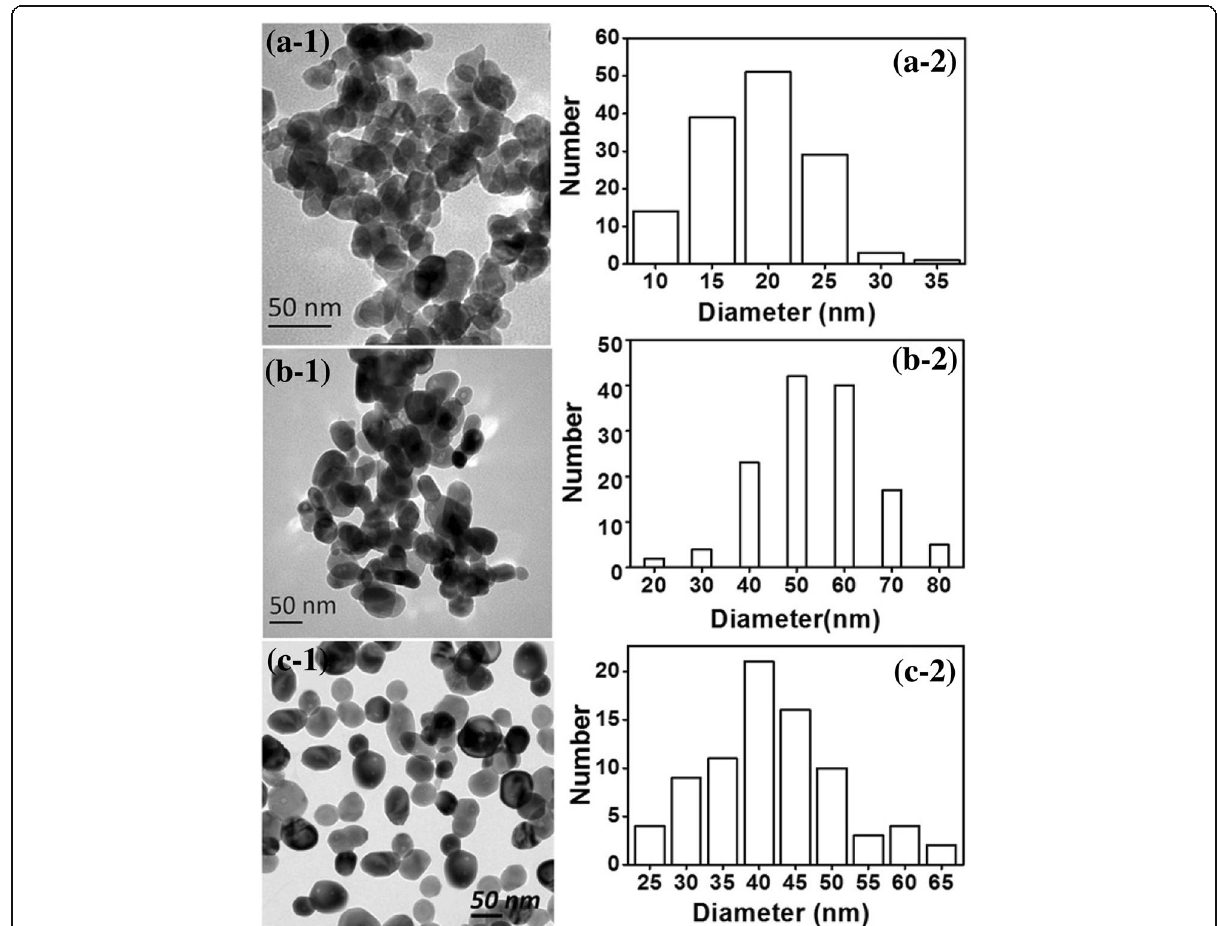
Fig. 8 TEM images of ZnO nanoparticles obtained from 65% ZnCl 2 aqueous solution obstruction by glycerol ( a ), starch ( b ), and cellulose ( c )